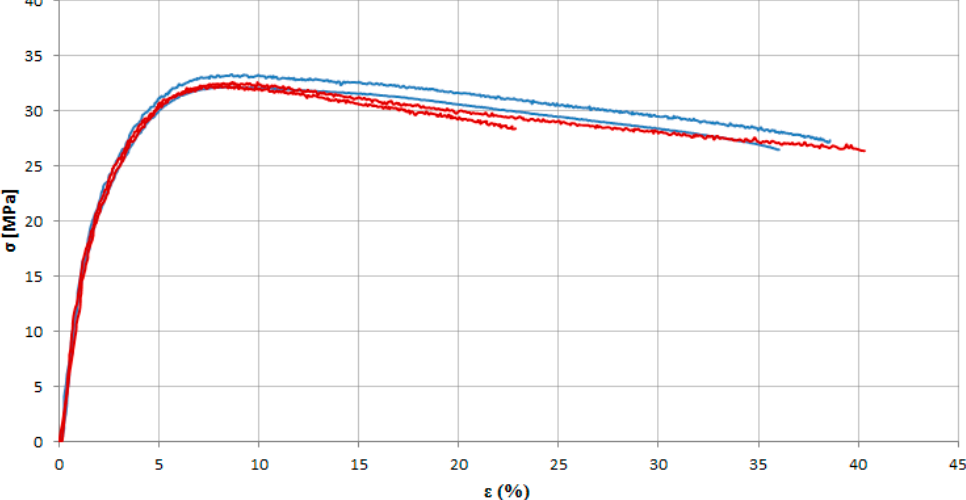
Figure 17. Stress–strain curves obtained from uniaxial tensile tests performed in the biaxial testing machine on MEB ((horizontal axis—blue curves; vertical axis—red curves) compared with the ones performed in a universal testing machine (in black). Figure 18 shows a specimen after testing, which presents a uniform distribution in the gauge zone (lighter area), but also a necking region formed at the end of the test. Figure 18. Uniaxial tensile test sample after testing.